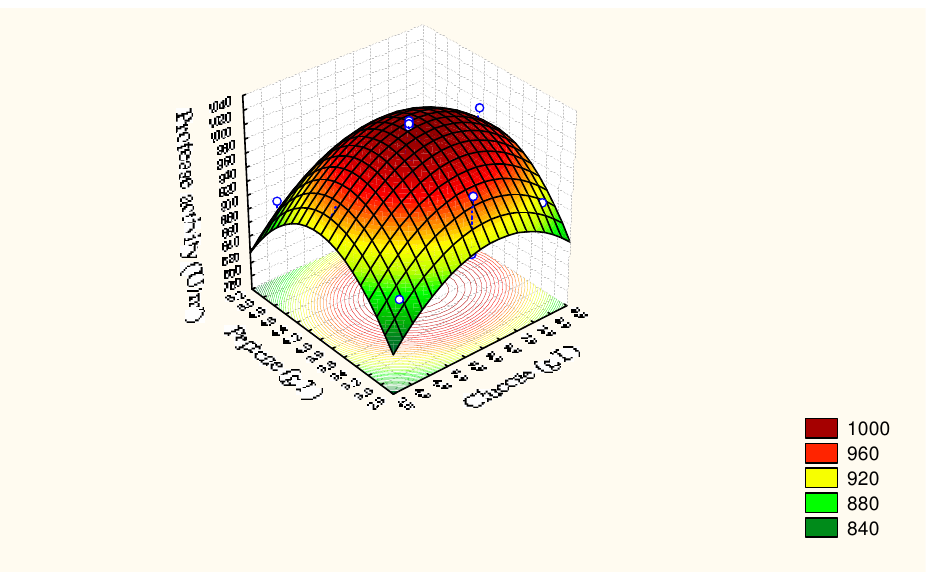
Figure 3(a). Effect of Glucose & Peptone on protease activity